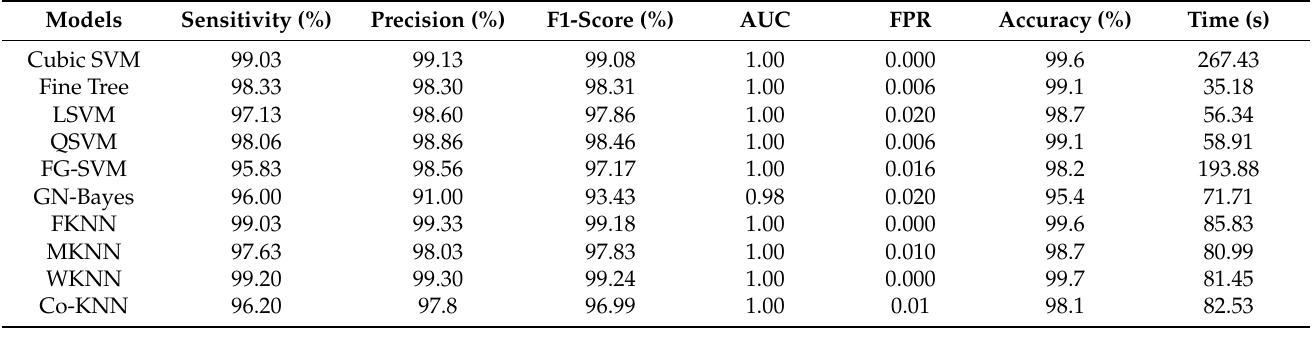
Figure 14. Fine-tuned MobilenetV2 TPR for MIAS. Table 9. Classification results using Fine-tuned Nasnet deep features for MIAS.